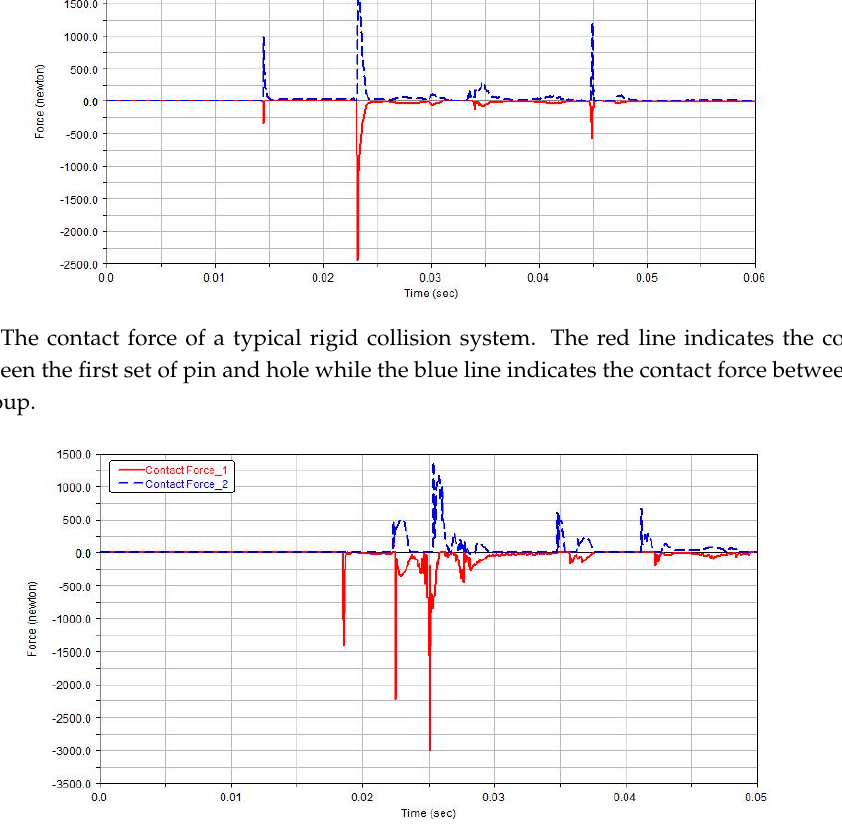
Figure 9. The contact force of the double-elastic collision system. The red line indicates the contact force between the first set of pin and hole while the blue line indicates the contact force between the second group.